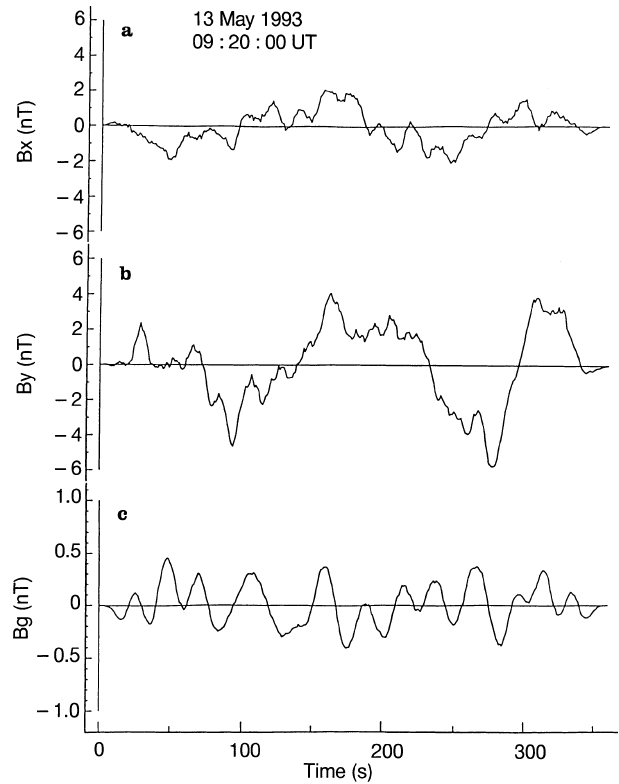
Fig. 6a–c. The simultaneous modified B-field signal records for 13 May 1993, 09:20:00–09:26:00 UT, a x -Freja, b y -Freja, c